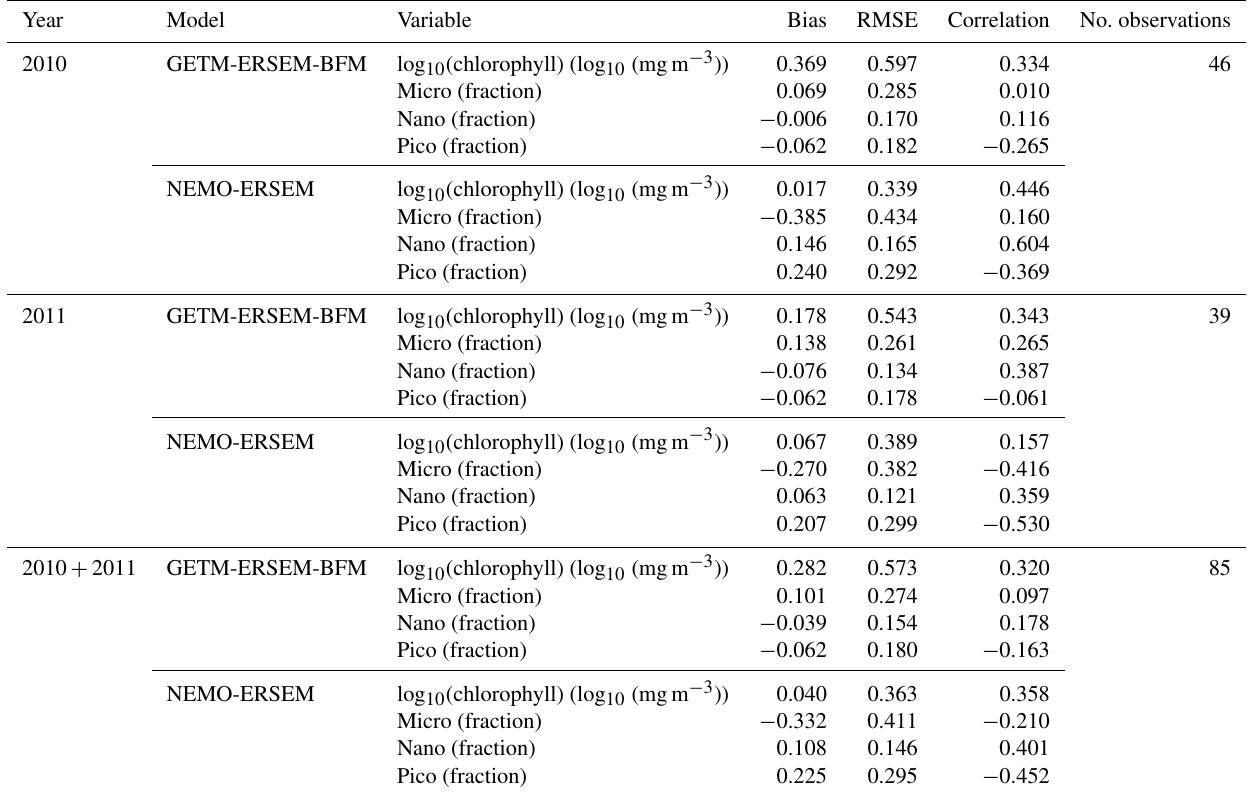
Table 3. Statistical comparison of log 10 (chlorophyll) and phytoplankton size classes against IBTS observations.